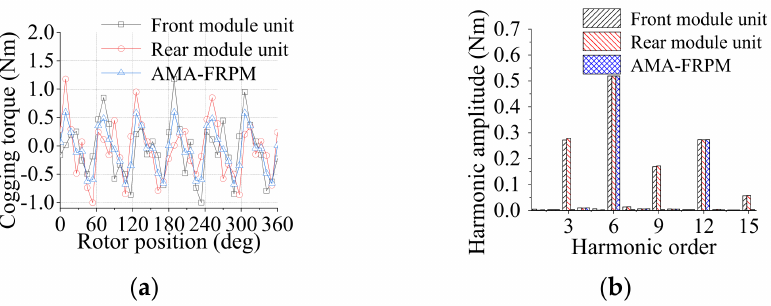
Figure 8. Cogging torques of the AMA-FRPM machine and a single module. ( a ) Cogging torque waveforms. ( b ) Harmonic distributions.